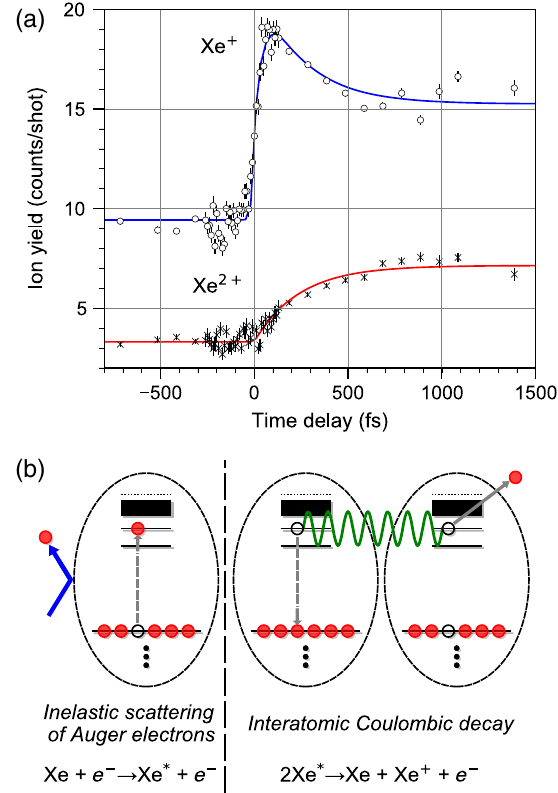
FIG. 2. Ultrafast dynamics of XFEL-induced nanoplasma. (a) Xe þ and Xe 2 þ yields as a function of the time delay of the NIR-probe pulse (800 nm) with respect to the XFEL-pump pulse (5.5 keV). The experimental Xe þ and Xe 2 þ yields are given by circles and crosses, respectively. The solid curves show results of the theoretical modeling of the process of NIR laser heating up of XFEL-induced nanoplasma, leading to the gradual increase of the Xe þ and Xe 2 þ yields, as well as the process of formation of excited atoms Xe (cid:3) that can pairwise undergo interatomic Coulombic decay (ICD), or alternatively be directly ionized by the delayed NIR-probe pulse, resulting in a sharp jump and a slower depletion in the Xe þ yield. The highly excited states are formed by the inelastic scattering of the Auger electrons during the early stages of nanoplasma formation. (b) Schematic dia- grams for the inelastic scattering of Auger electrons and the